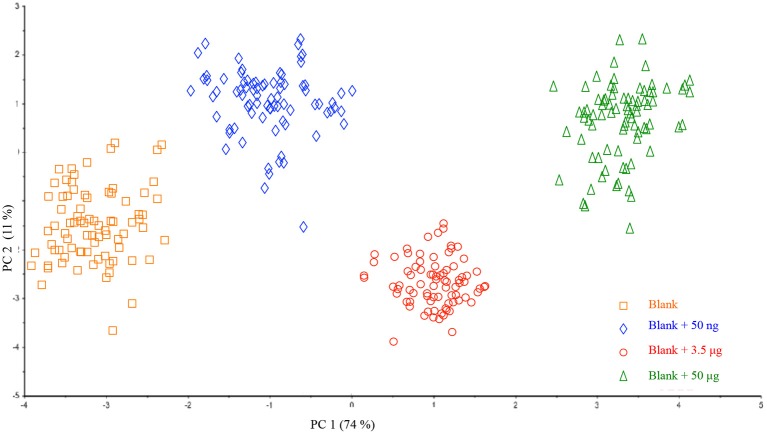
Scores plot of the Principal Component Analysis performed on the entire dataset of collected samples.